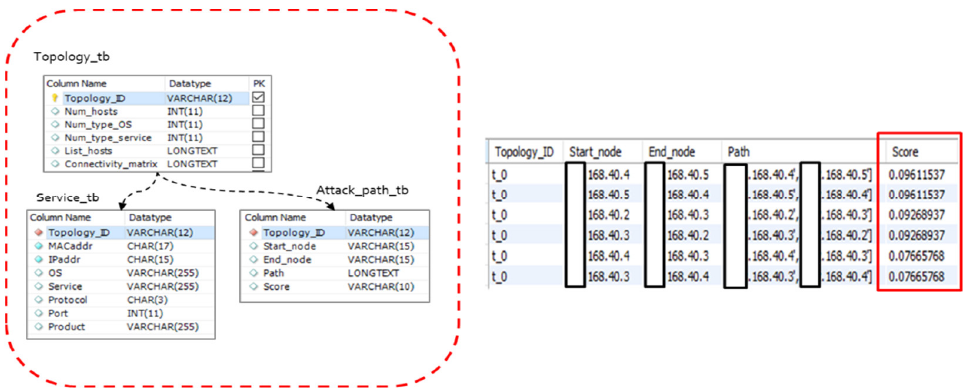
Figure 1. Concept map of data collection and processing.